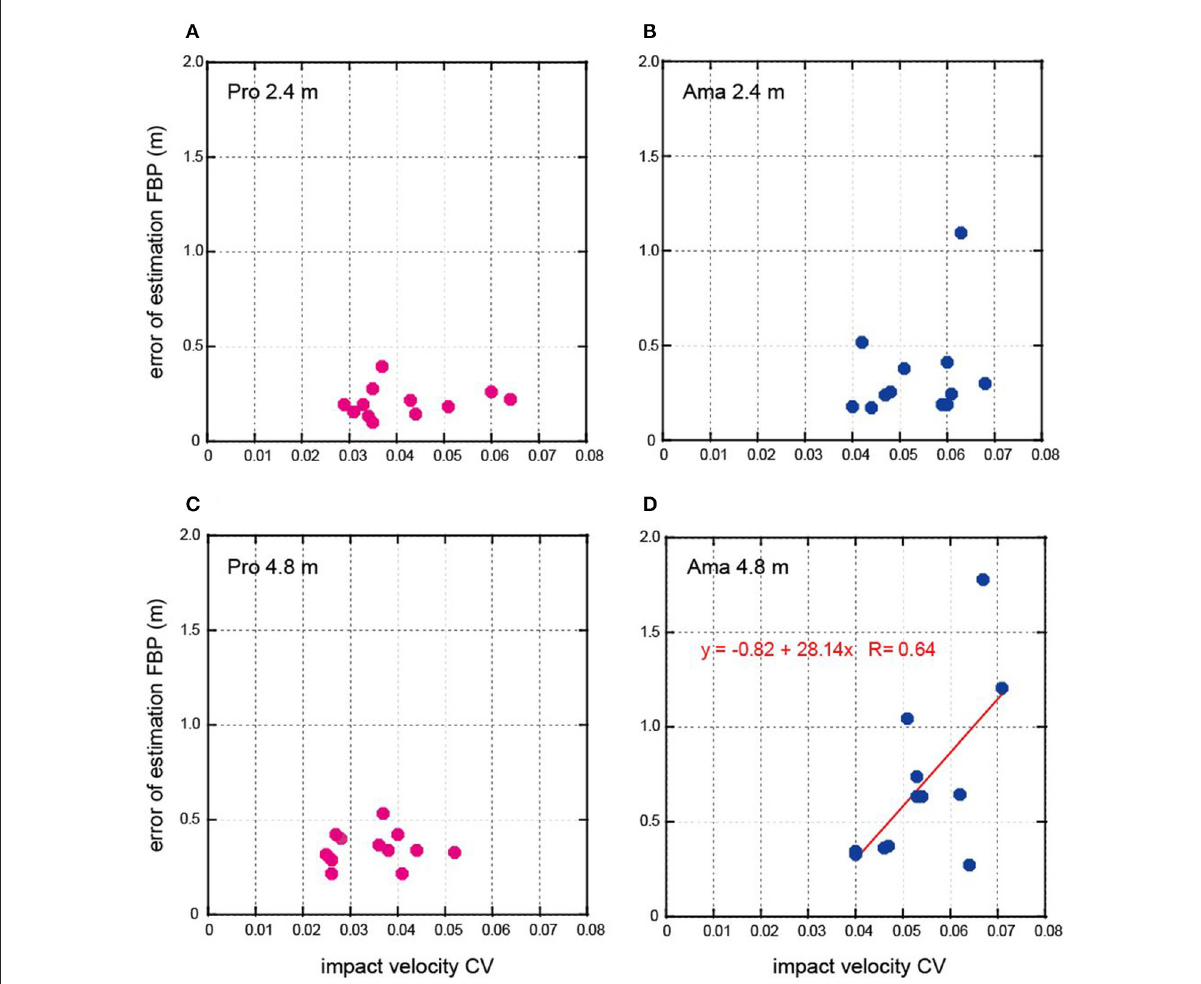
FIGURE4 The results of the relationship between the peak velocity CV and the error of estimation FBP. (A,C) Show the results of professionals (Pro) for 2.4m and 4.8m putting, and (B,D) show the results of amateurs (Ama) for 2.4m and 4.8m